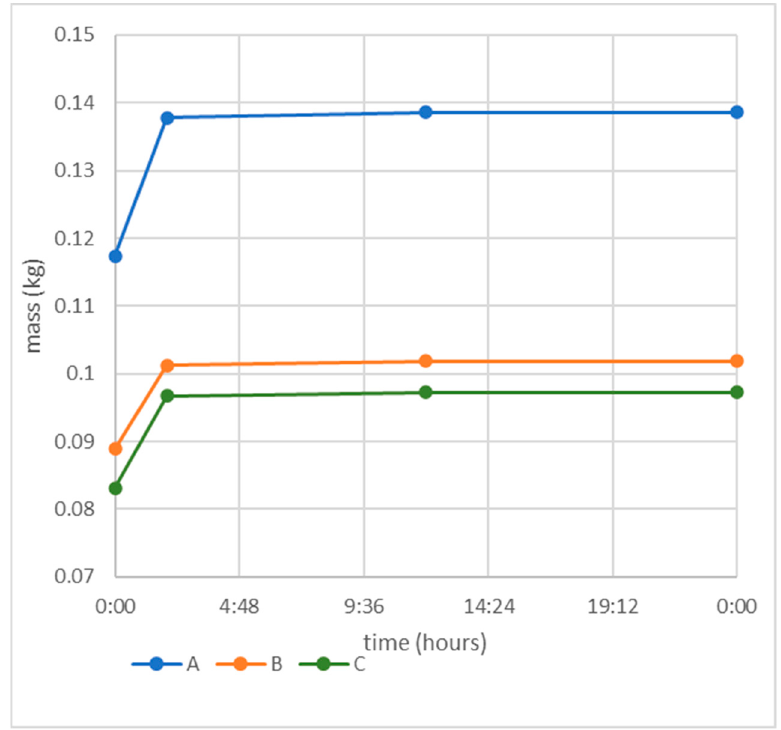
Figure 15. Water absorption chart for the three samples A, B, and C.